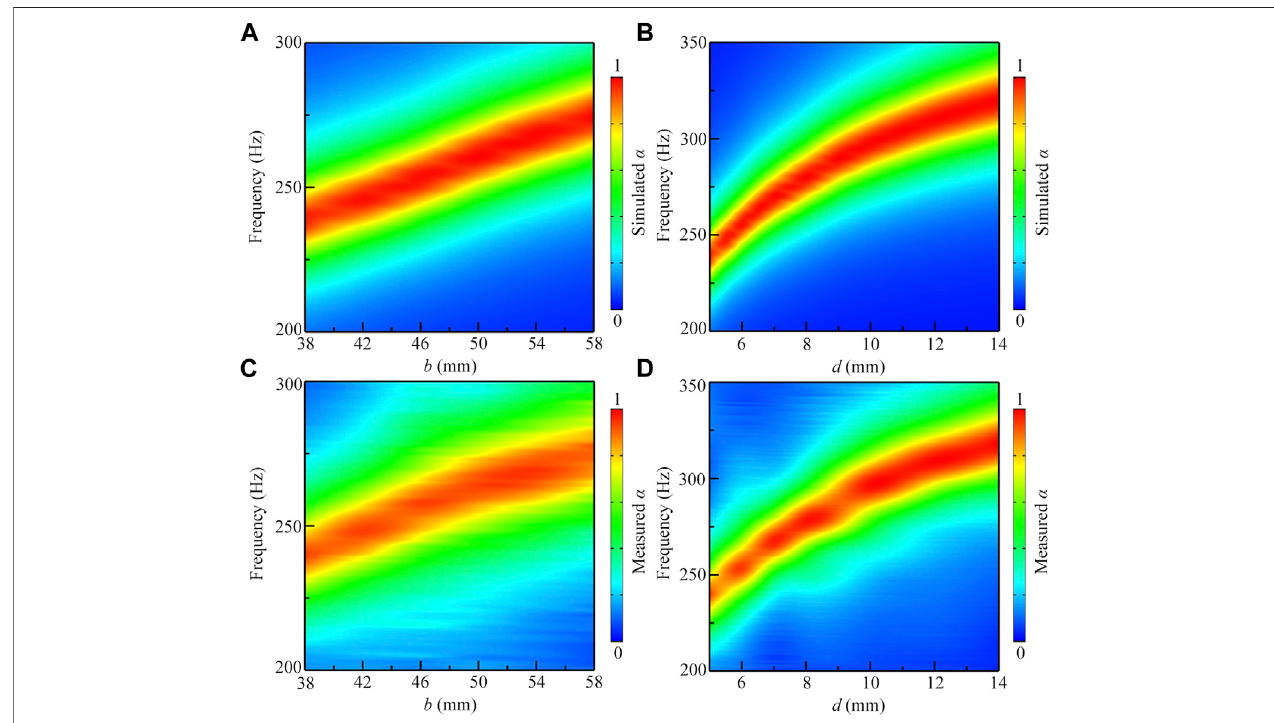
FIGURE 4 | Simulated sound absorption spectra as a function of parameters (A) b and (B) d , and the corresponding measured sound absorption spectra for the parameters (C) b and (D) d , in which the other parameters remain unchanged.